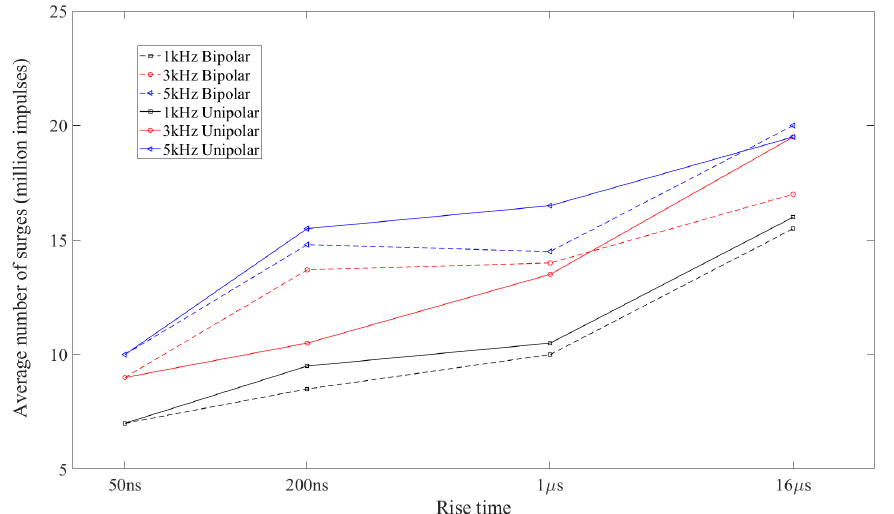
Figure 8. Average number of surges to failure of Type I crossed pair specimens subjected to square wave voltage having different rise times and frequencies; figure extrapolated from experimental data of the work conducted by Wang et al.